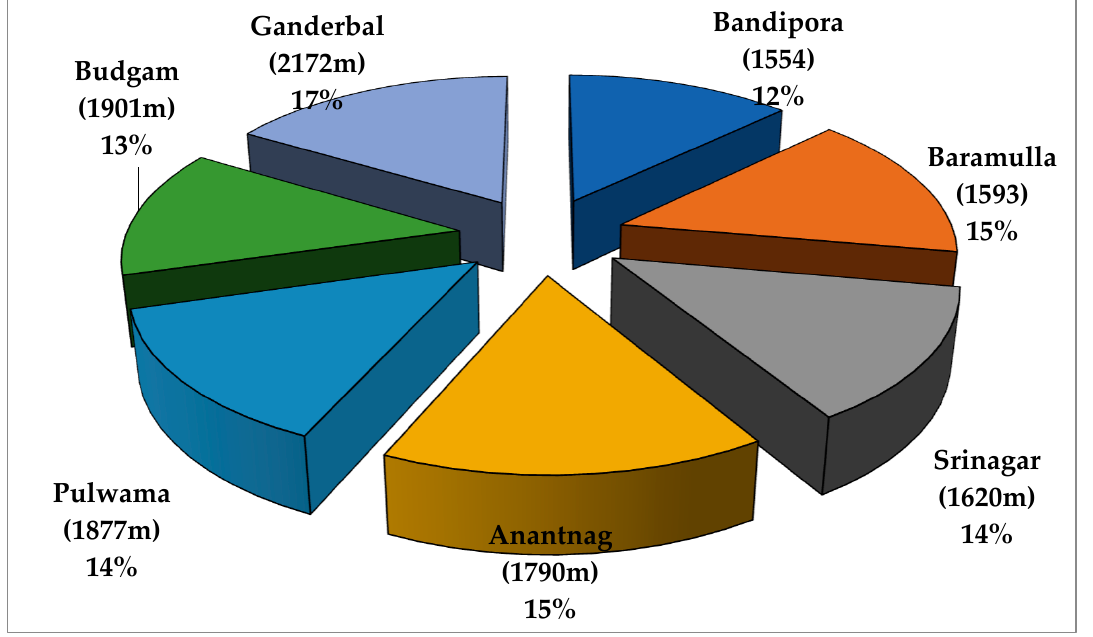
Figure 2. Percentage of secondary metabolites identified by GC-MS analysis at different altitudes and localities in C. intybus L.